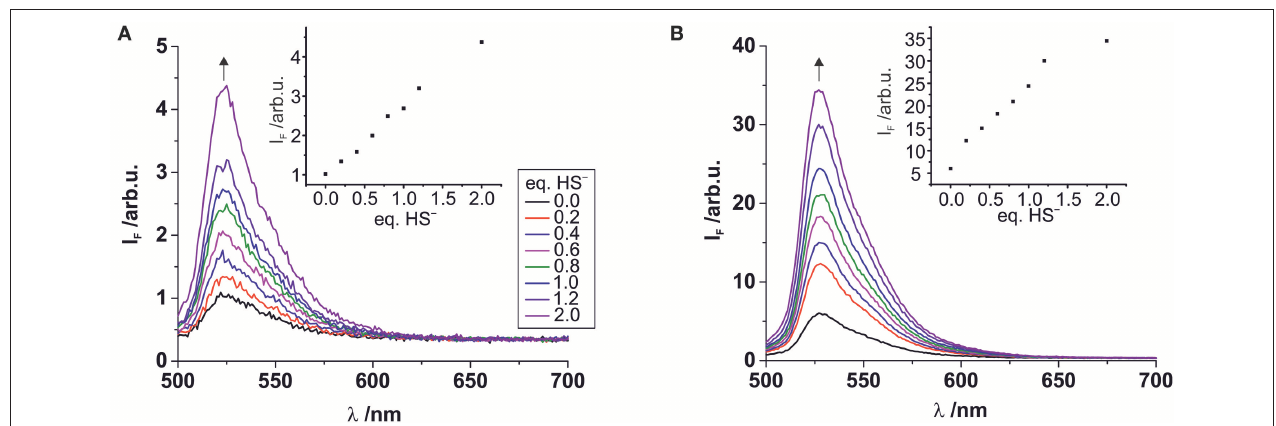
FIGURE 2 | Fluorescence titrations of 10 − 7 M solutions of complexes 1 (A) and 2 (B) in acetonitrile with increasing amounts of aqueous Na 2 S solution. Excitation wavelength 490nm. Insets: Plots of the fluorescence intensity at the emission maximum vs. the number of added HS − eq., relative to the BODIPY-cobaloxime complexes (legend with color code in graph A applies to both